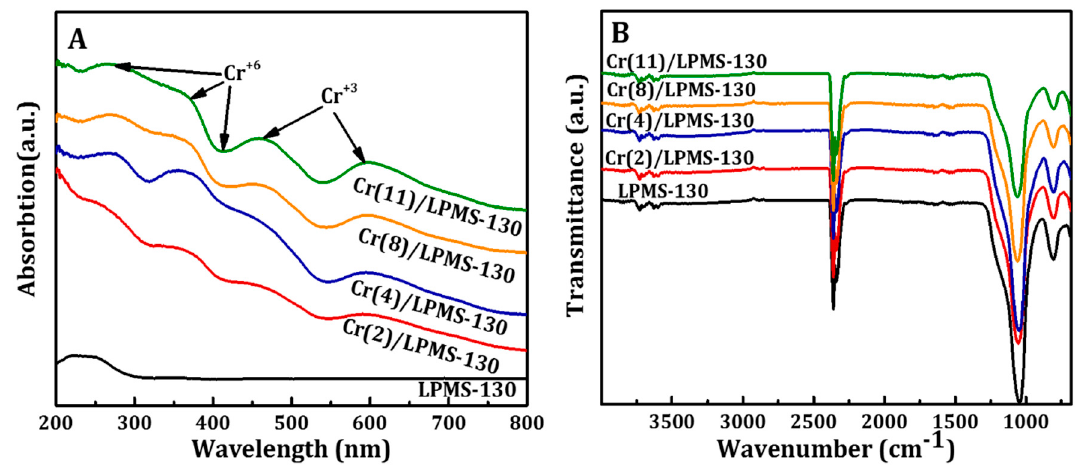
Figure 7. ( A ) UV-Vis-DR spectra and ( B ) FTIR patterns of Cr(y)/LPMS-130 at various Cr loading wt %.